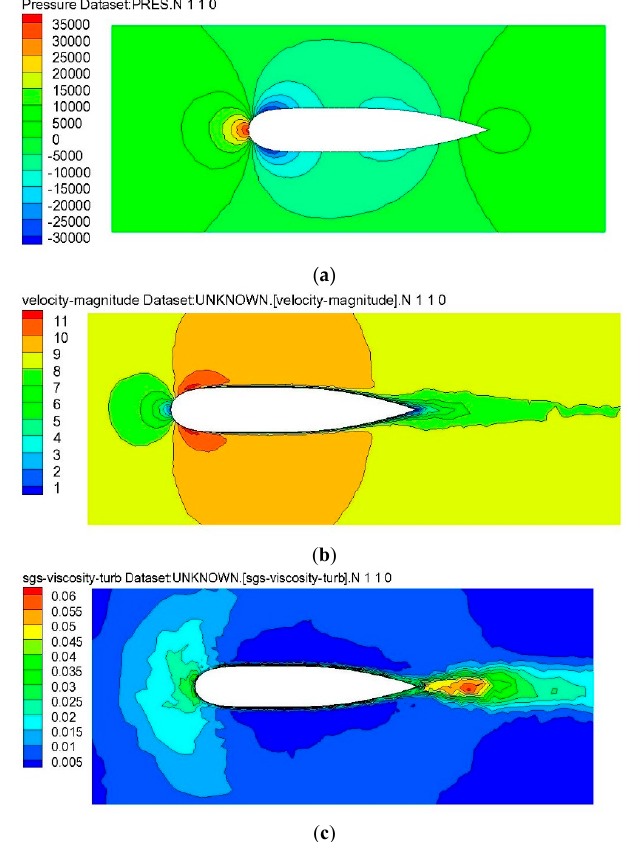
Figure 6. Contours of the flow field at plane A: ( a ) pressure contour; ( b ) velocity contour; and ( c ) kinetic turbulent energy.